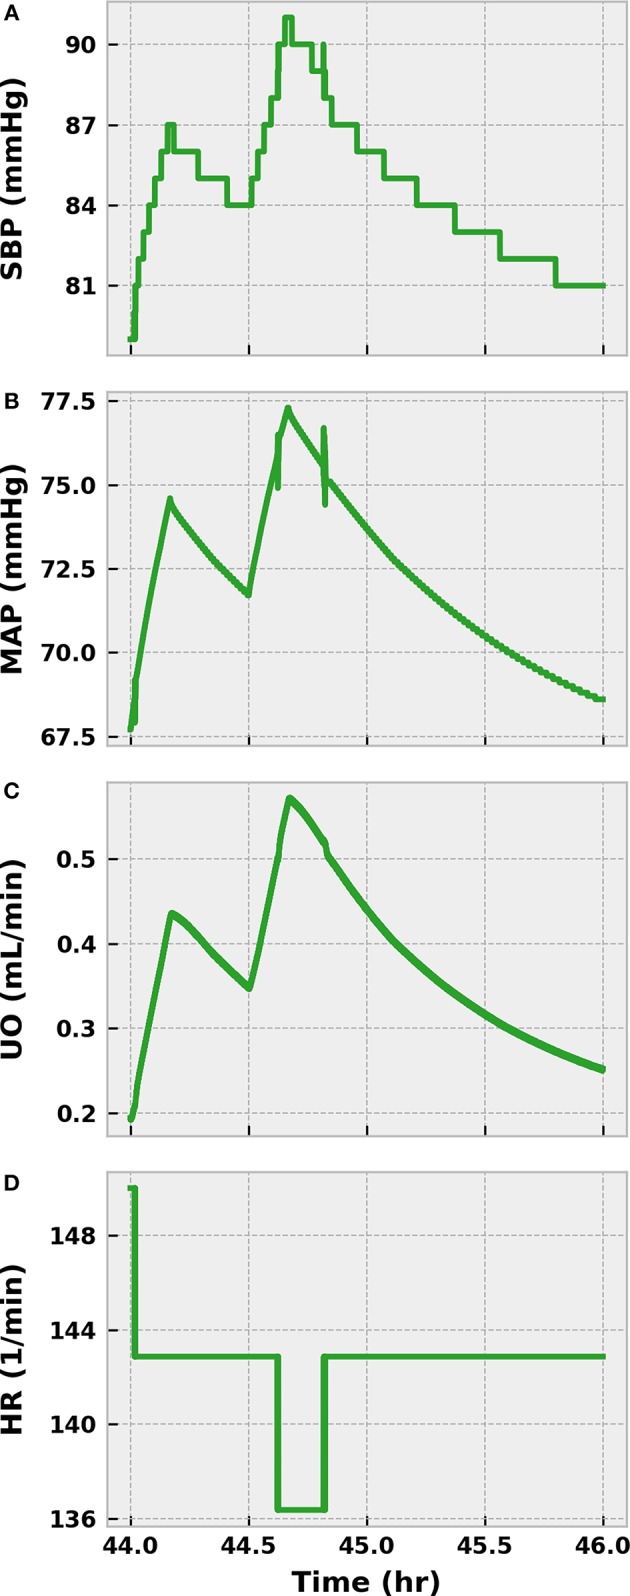
The response of the virtual patient to 1,000 mL of saline infused in two separate 500 mL boluses at 44 and 44.5 h post-infection. SBP (A) and MAP (B) transiently increase after fluid administration, but decline over the subsequent hour of observation. SBP quickly falls below 90 mmHg, the target resuscitation value in the REFRESH protocol. MAP trends downward and approaches 65 mmHg, which would characterize severe hypotension. UO shows a similarly shortlived improvement after fluid dosing (C) and remains below 0.625 mL/min, our threshold for hypovolemia. The improvement in blood pressure reduces some of the burden on the baroreflex, causing a small decrease in HR (D). As the virtual patient is exhibiting fluid resistant hypotension, the patient can be said to be in a state of septic shock.